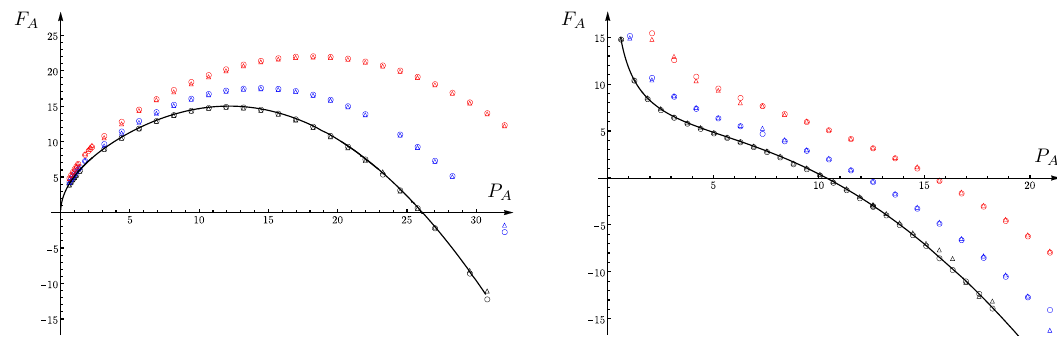
F A <latexit sha1_base64="YTYBsv/h2RO7/Q4ot8DBz2OgYKI=">AAAB6nicbVDLSgNBEOz1GeMrxqOXIUHwFHajoMeIIh4jmgckS5idzCZDZmaXmVkhLPkELx4U8Sr+hX/gyZt/4+Rx0MSChqKqm+6uIOZMG9f9dpaWV1bX1jMb2c2t7Z3d3F6+rqNEEVojEY9UM8CaciZpzTDDaTNWFIuA00YwuBj7jXuqNIvknRnG1Be4J1nICDZWur3qnHdyRbfkToAWiTcjxUrm8yN/+V6odnJf7W5EEkGlIRxr3fLc2PgpVoYRTkfZdqJpjMkA92jLUokF1X46OXWEDq3SRWGkbEmDJurviRQLrYcisJ0Cm76e98bif14rMeGZnzIZJ4ZKMl0UJhyZCI3/Rl2mKDF8aAkmitlbEeljhYmx6WRtCN78y4ukXi55x6XyjU3jBKbIwAEU4Ag8OIUKXEMVakCgBw/wBM8Odx6dF+d12rrkzGb24Q+ctx/GaJBf</latexit>